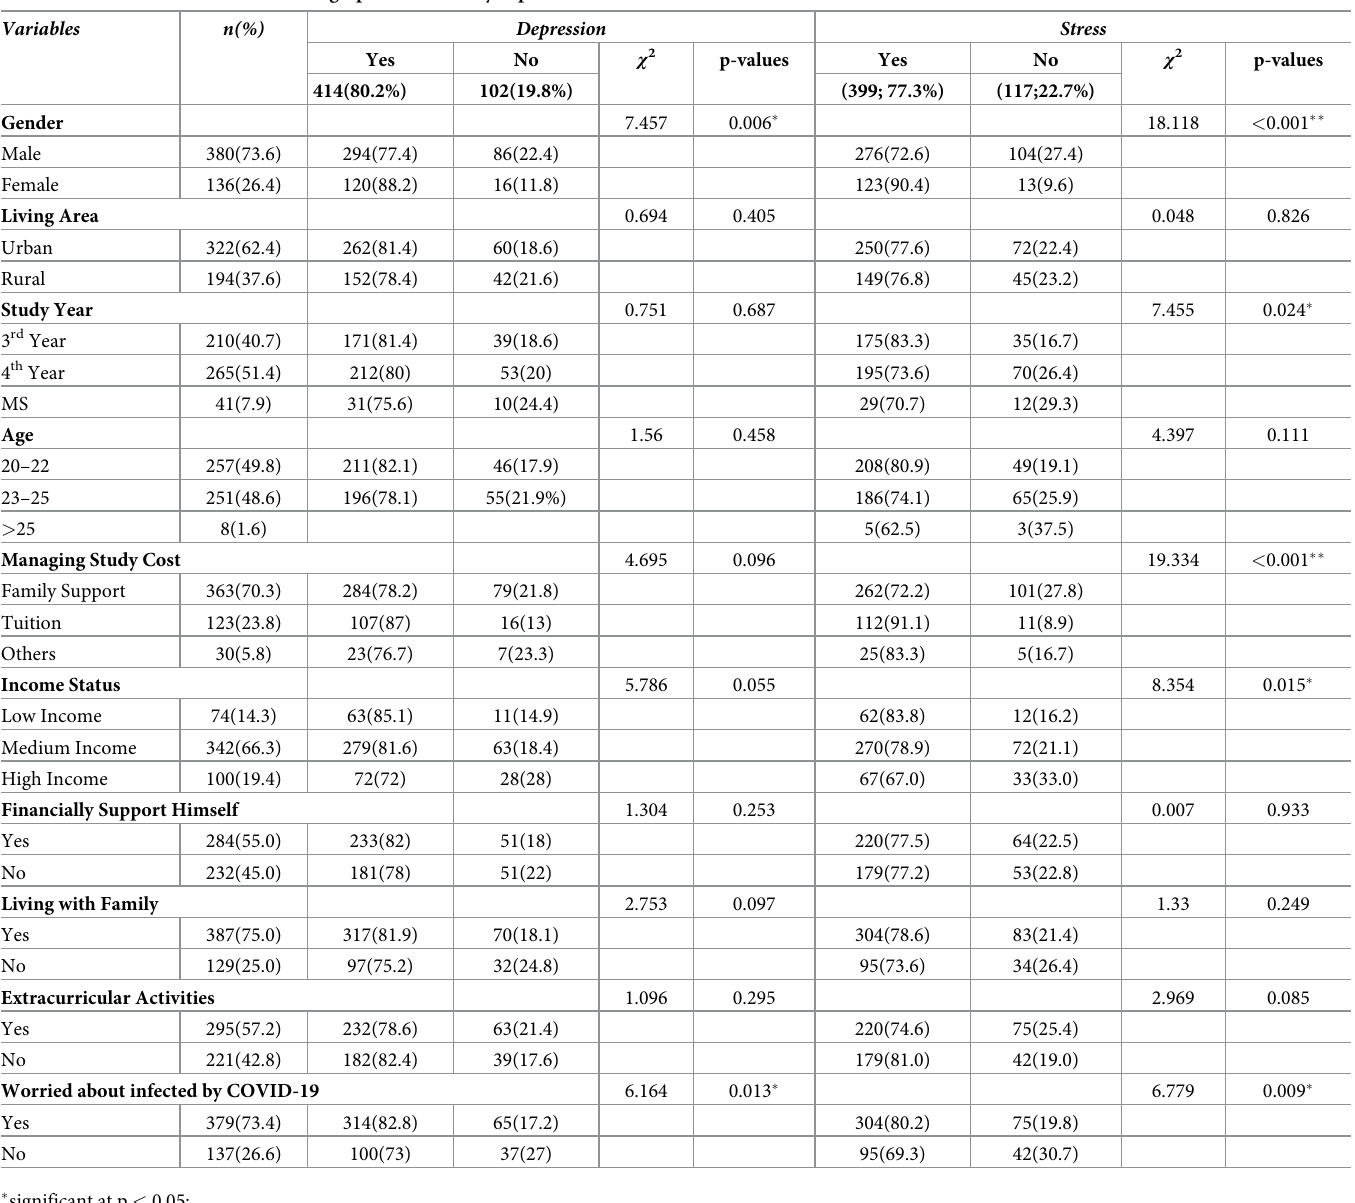
Table 1. Distribution of the socio demographic variables by depression and